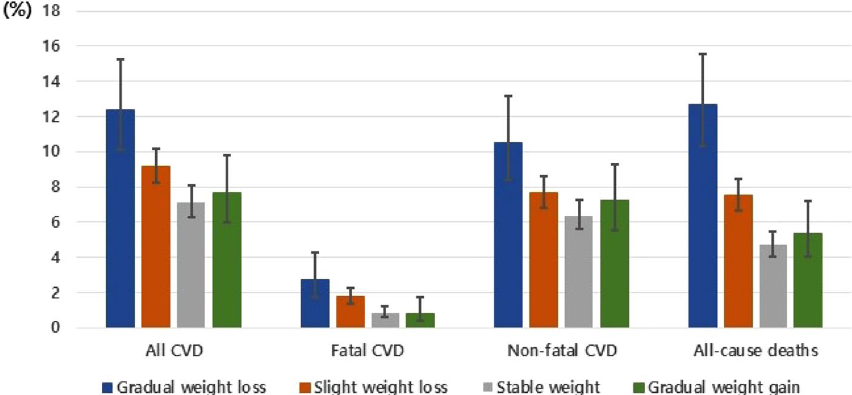
Figure 2. Incident cases proportion (%) with 95% CI among weight-trajectory groups. CVD cardiovascular disease, 95% CI 95% confidence interval.